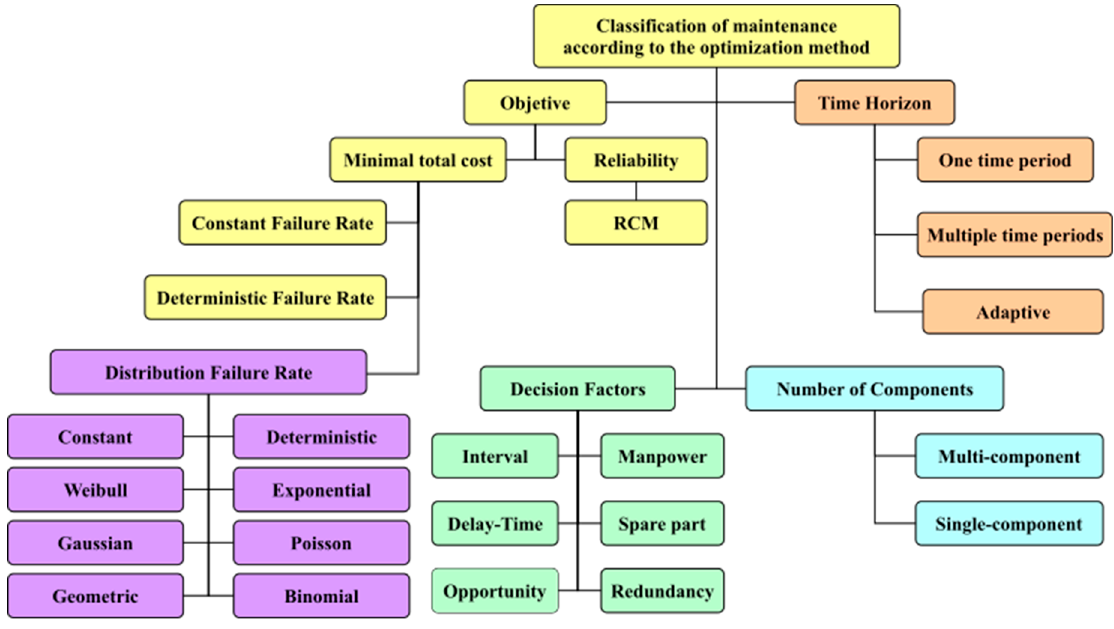
Figure 3. Maintenance Models according to the optimization method. “Source [48–53], own elaboration.”.